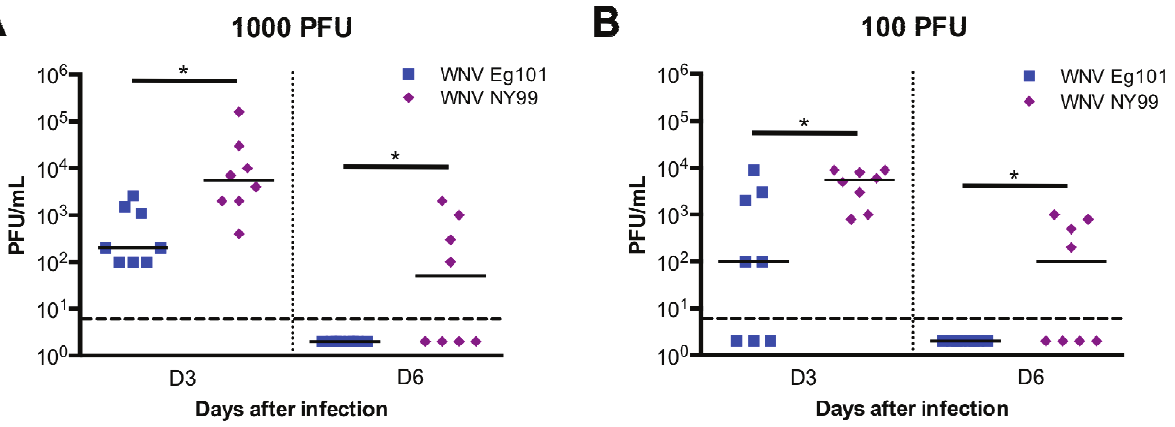
Figure 2. Virus titers in the serum of WNV Eg101 and WNV NY99 and infected mice. The kinetics of virus replication and levels of WNV were determined in the serum of the mice infected with ( A ) 1000 PFU, and ( B ) 100 PFU of WNV Eg101 and WNV NY99 at indicated time-points by plaque assay. The data are expressed as PFU/mL of serum. Each data point represents an individual mouse, and data from two independent experiments are depicted (n = 8 mice per group). Data points below the horizontal dotted line are negative. The solid horizontal line signifies the median of eight mice per group. * p < 0.05.